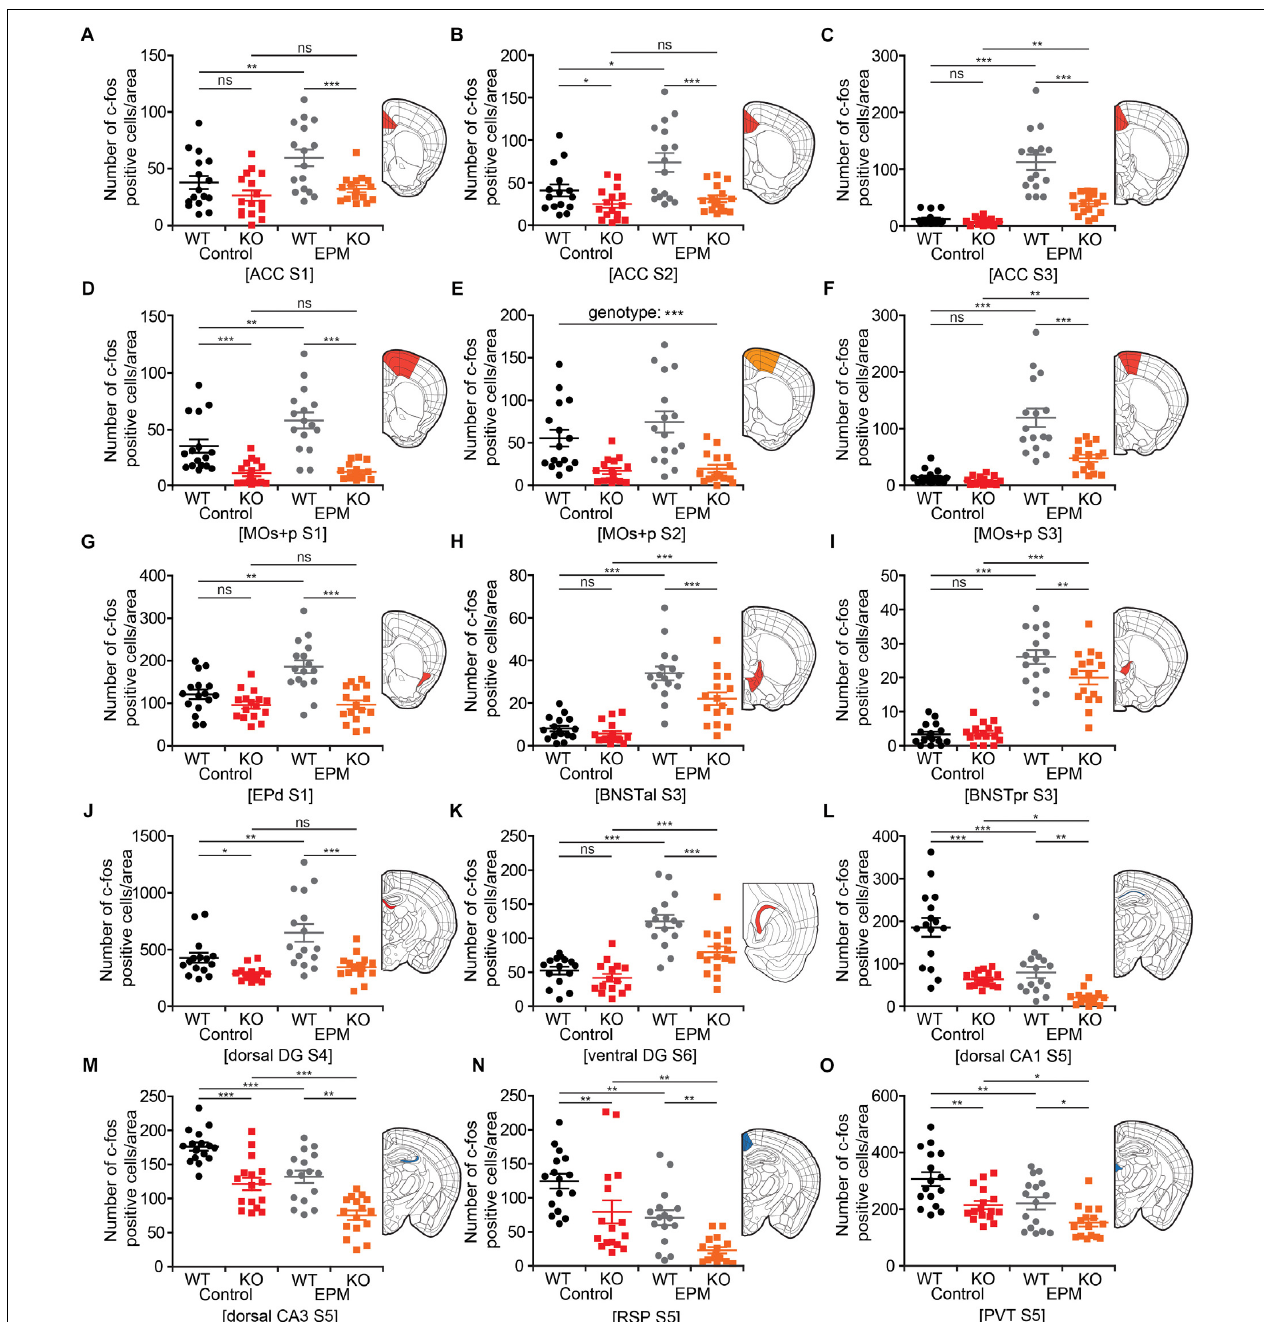
FIGURE 7 | Lrrc4c − / − brain regions with distinct changes in neuronal activity upon EPM stimulation. (A–K) Brain regions at examined brain sections (S) that show strong EPM-induced increases in c-fos levels (indicated by the number of c-fos-positive cells) in WT mice, but moderate or no increases in Lrrc4c − / − mice (3–4 months; male). Results for the colored regions within each brain diagram are indicated in the corresponding color-coded bar graphs. Blue and red shades in the brain diagrams indicate the statistical significance of both main factors or their interaction. Orange shades indicate statistical significance of only the genotype factor. n = 16 slices from 4 mice (WT), n = 16 (4) (KO), ∗ p < 0.05, ∗∗ p < 0.01, ∗∗∗ p < 0.001, ns, not significant, two-way ANOVA (genotype × stimulus) with Holm-Sidak multiple comparison test [ (A) interaction, F ( 1 , 63 ) = 2.14, p = 0.149; genotype, F ( 1 , 63 ) = 12.79, p = 0.0007; stimulus, F ( 1 , 63 ) = 6.51, p = 0.0133; WT (E vs. C), p = 0.0062, KO (E vs. C), p = 0.4444, Control (WT vs. KO), p = 0.1401, EPM (WT vs. KO), p = 0.0007; (B) two-way ANOVA; interaction, F ( 1 , 63 ) = 1.99, p = 0.1631; genotype, F ( 1 , 63 ) = 18.11, p < 0.001; stimulus, F ( 1 , 63 ) = 5.01, p = 0.0289; WT (E vs. C), p = 0.0123, KO (E vs. C), p = 0.5608, Control (WT vs. KO), p = 0.0489, EPM (WT vs. KO), p = 0.0002; (C) two-way ANOVA; interaction, F ( 1 , 63 ) = 22.42, p < 0.001; genotype, F ( 1 , 63 ) = 29.45, p < 0.001; stimulus, F ( 1 , 63 ) = 85.22, p < 0.001; WT (E vs. C), p < 0.001, KO (E vs. C), p = 0.0023, Control (WT vs. KO), p = 0.6266, EPM (WT vs. KO), p < 0.001; (D) two-way ANOVA; interaction,